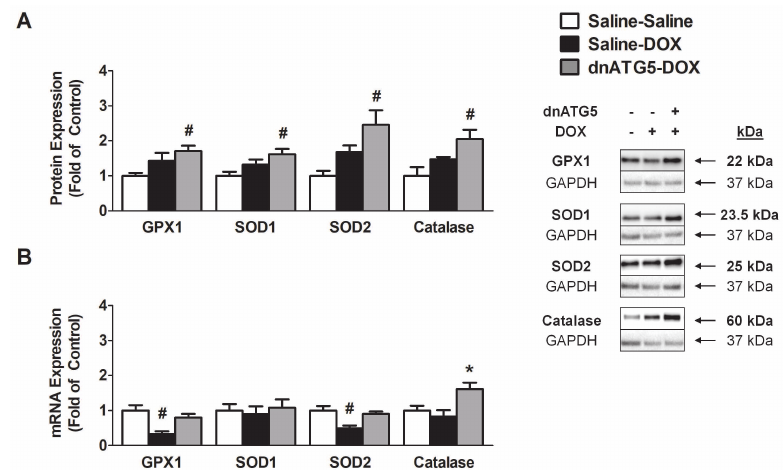
Figure 7. Endogenous antioxidant enzyme expression in the soleus. ( A ) Protein expression of glutathione peroxidase 1 (GPX1), superoxide dismutase 1 (SOD1), superoxide dismutase 2 (SOD2), and catalase. ( B ) mRNA expression of GPX1, SOD1, SOD2, and catalase. Values are represented as means ± SEM. Representative Western blot images are shown to the left of the graph. * significantly di ff erent versus all groups ( p < 0.05). # significantly di ff erent versus Saline-Saline ( p < 0.05).